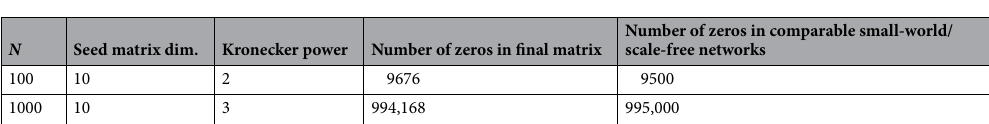
Table 1. The number of zeros is slightly different in Kronecker–Leskovec networks compared to small-world/ scale-free networks of the same network size N . For the given results, seed matrices with 82 zeros were used.